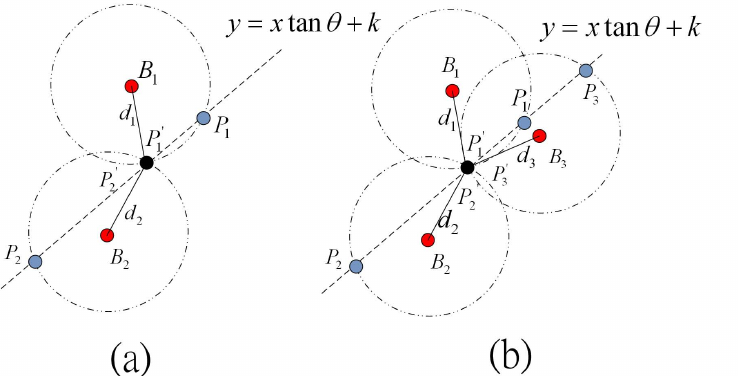
Figure 3. Location determination of normal node: (a) with help of two beacon nodes, (b) with help of three beacon